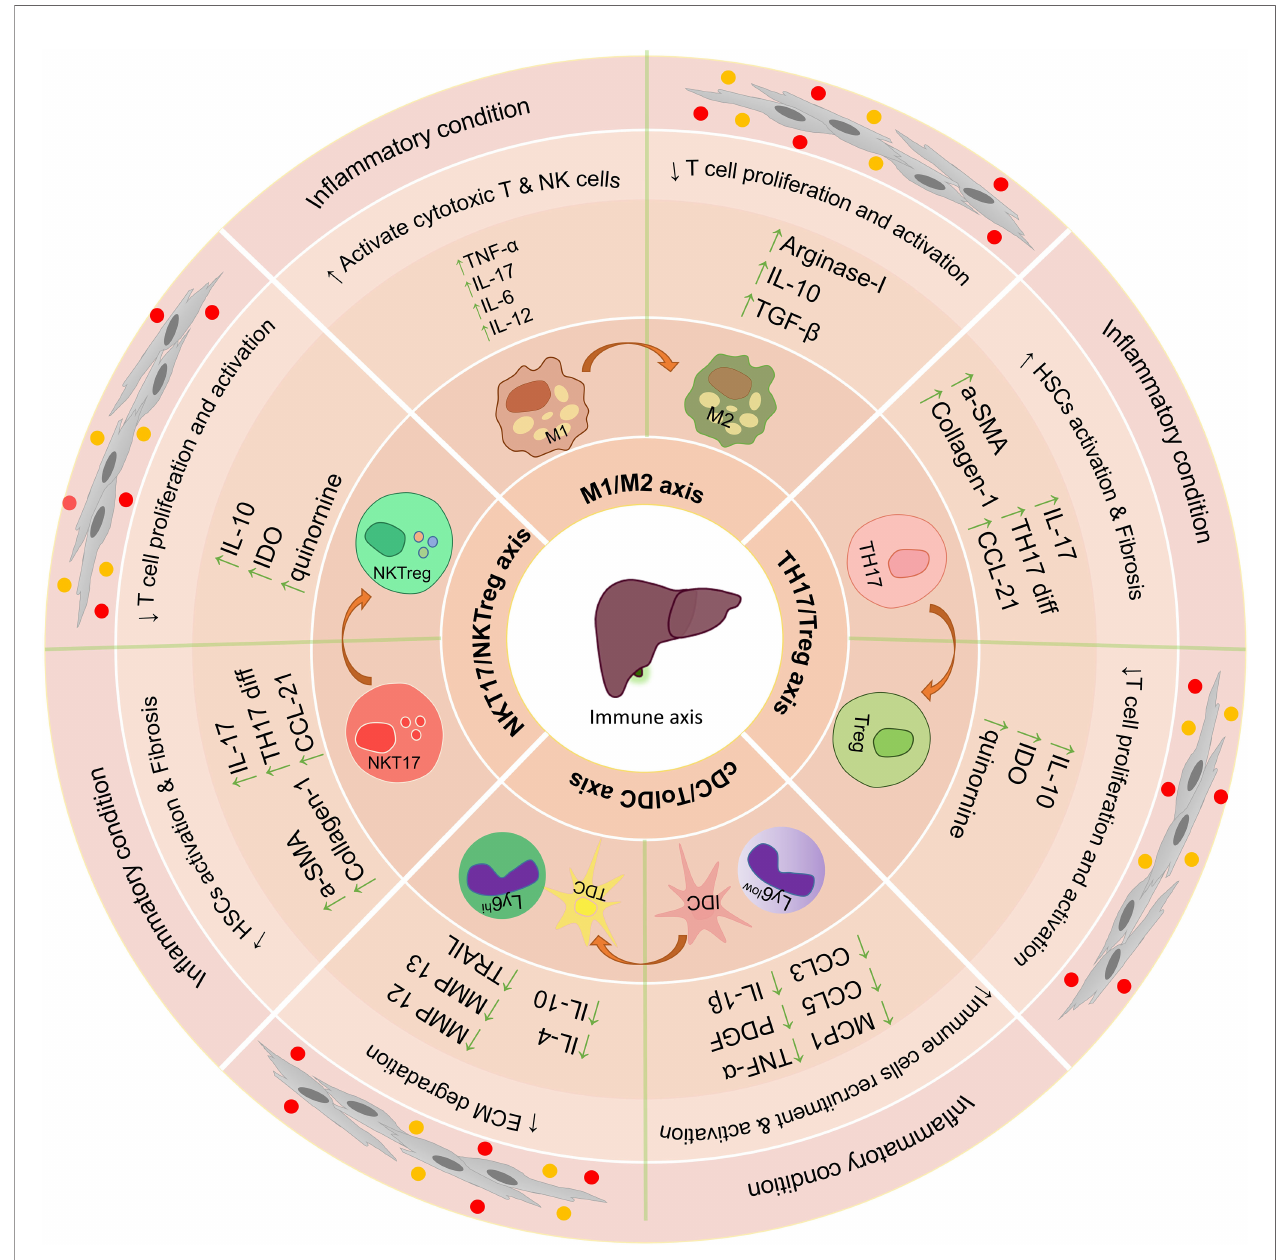
FIGURE 3 | The effect of using mesenchymal stem cells and extracellular vesicles on the important axis of the immune system in the liver. Immunomodulatory properties of mesenchymal stem cells and their extracellular vesicles lead to the suppression of in fl ammatory responses in the liver ’ s microenvironment and increase anti-in fl ammatory responses. Some of the most important axis of the immune system involved in liver disease is TH17/Treg, NKT17/NKTreg, and M1/M2. The use of mesenchymal stem cells and extracellular vesicles leads to suppression of function Th17, NKT17, M1, and IDC and increase the differentiation and function of Treg, NKTreg, M2, and Tol DCs; HSCs, hepatic stellate cells; KCs, Kupffer cells; LSECs, hepatic sinusoidal endothelial cells; HEPs, Hepatocytes; Tol DCs, Tolerogenic dendritic cells; cDC, Classic dendritic cells; ECM, extracellular matrix; MSCs, Mesenchymal stromal/stem cells;, M1 Macrophage type 1; M2, Macrophage type 2; MMPs, Matrix metalloproteinase; EVs, Extracellular